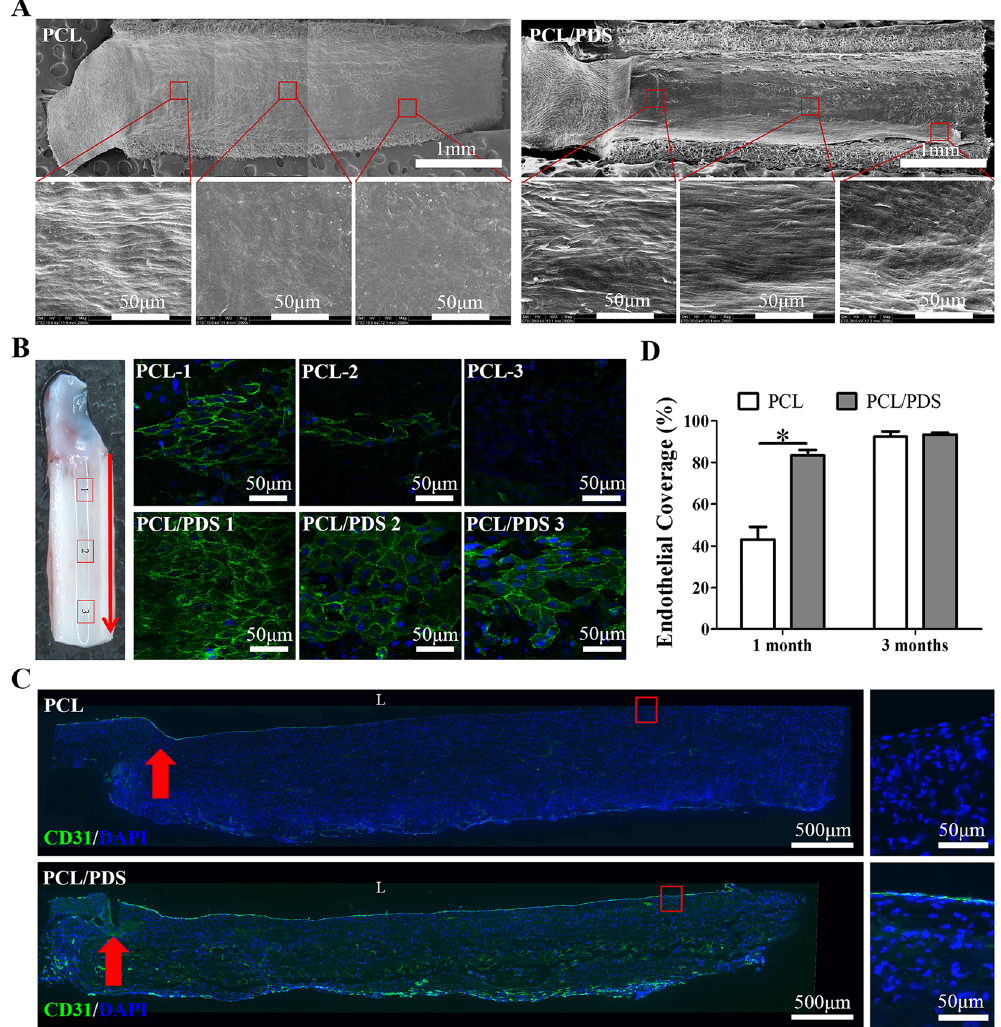
Figure 3. Endothelialization formation of the explanted grafts at 1 month after implantation. ( A ) The lumen surface of explanted grafts was observed by SEM. ( B ) The endothelial coverage of grafts was observed by En face immunostaining using CD31 antibody (Red arrows: blood flow direction). ( C ) Endothelialization was analyzed by immunofluorescence staining of longitudinal sections of grafts using CD31 antibody (L: lumen; Red arrows: suture site). ( D ) The endothelial coverage at 1 and 3 months was calculated based on the longitudinal sections with CD31 staining. * p <